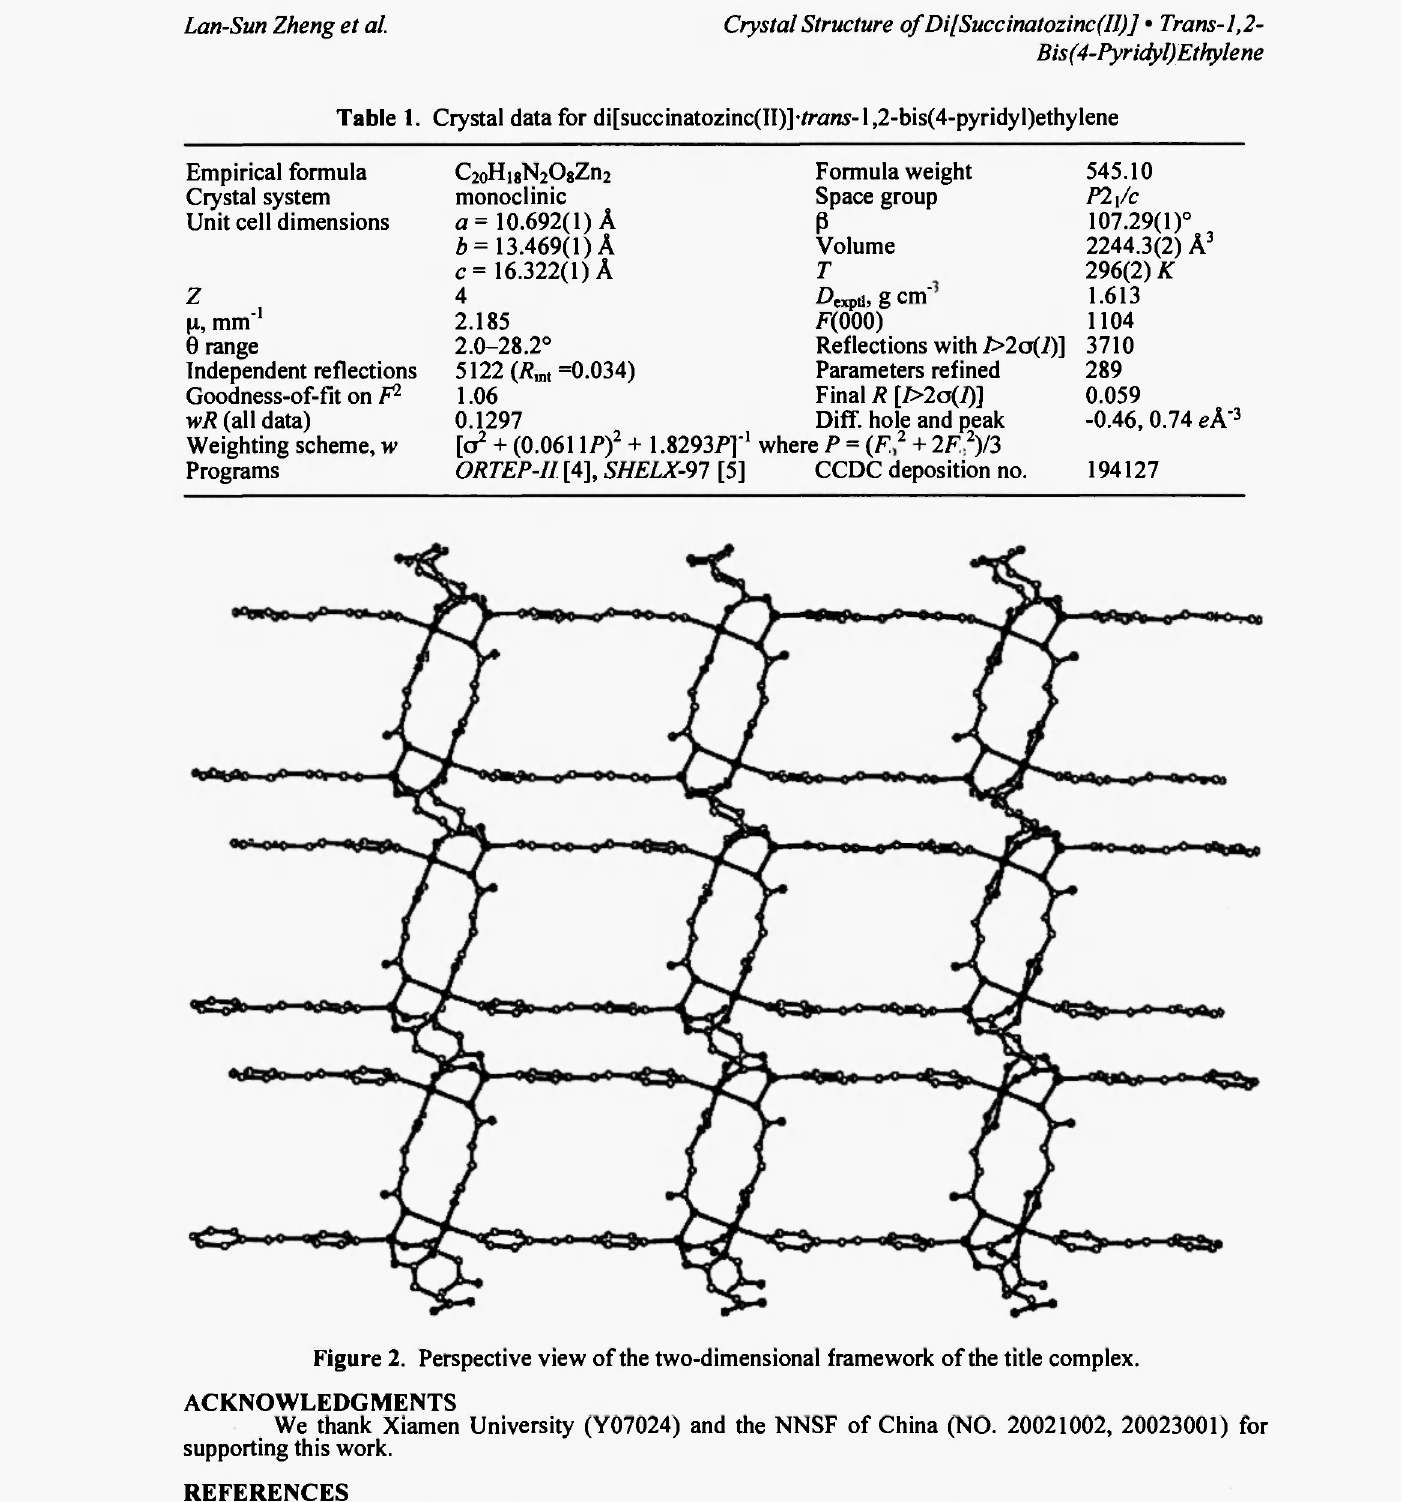
Table 1. Crystal data for di[succinatozinc(II)] /ra«s-l,2-bis(4-pyridyl)ethylene